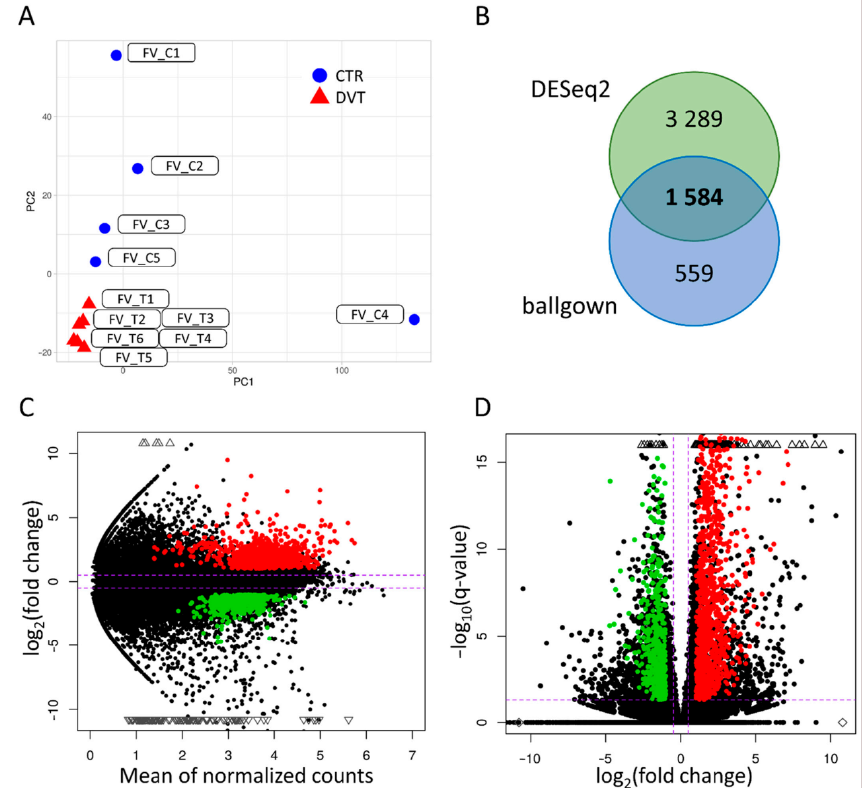
Figure 1. Expression profiles overview of DVT. ( A ) Graphical representation of the first (PC1) and second (PC2) principal components affecting the sample expression pattern of deep vein thrombosis (DVT; n = 6) and control (CTR; n = 5) libraries. ( B ) Venn diagram with the number of differentially expressed genes (DEGs) tagged by DESeq2 and ballgown methods. The middle number describes the consensus of DEGs distinguished by both methods. ( C ) MA chart with logarithmic values of fold change (logFC; Y axis) plotted against normalized counts (X axis) for DVT-affected and CTR libraries. Two horizontal dotted lines refer to the cut value of log2FC >1 and < − 1. ( D ) Volcano plot depicts log2FC plotted against log-normalized p -values. The dotted horizontal line indicates negative logarithmic adjusted p -value (0.05) cut-off. Dotted vertical lines indicate cut-off values of logFC. ( C , D ) Red dots illustrate upregulated differentially expressed genes (DEGs); green dots represent downregulated DEGs; black dots are not significant transcripts, according to DESeq2 and ballgown